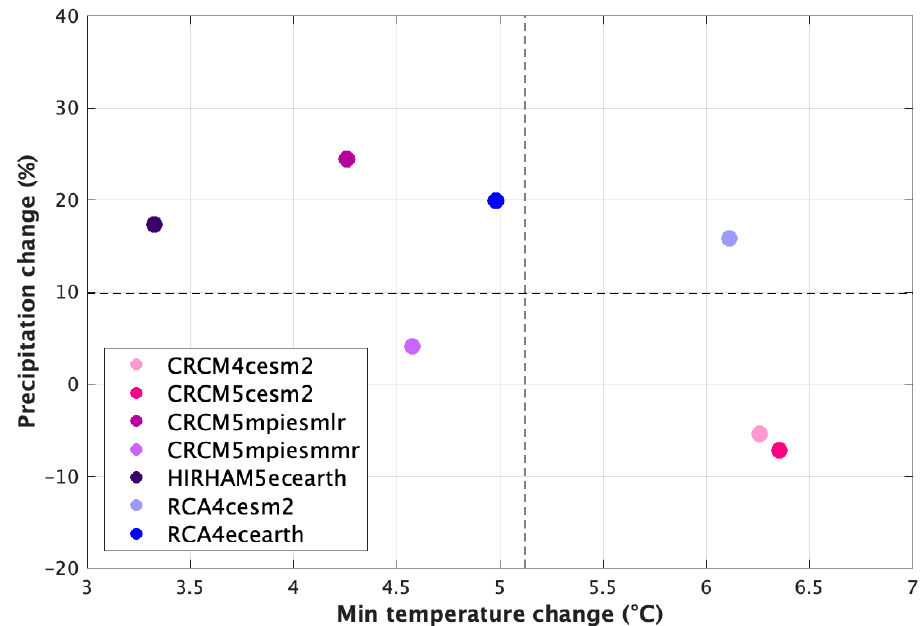
Figure 18. Projected changes from trends in growing season (May–August) minimum temperature and total precipitation (each colored circle represents a different RCM, and the dashed lines represent average climatic changes).